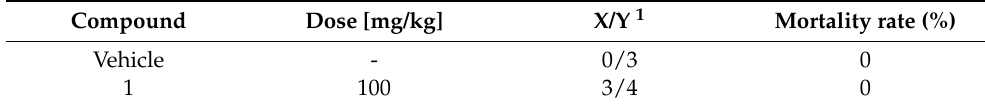
Table 3. Anticonvulsant activity of the compound 1 in 6-Hz